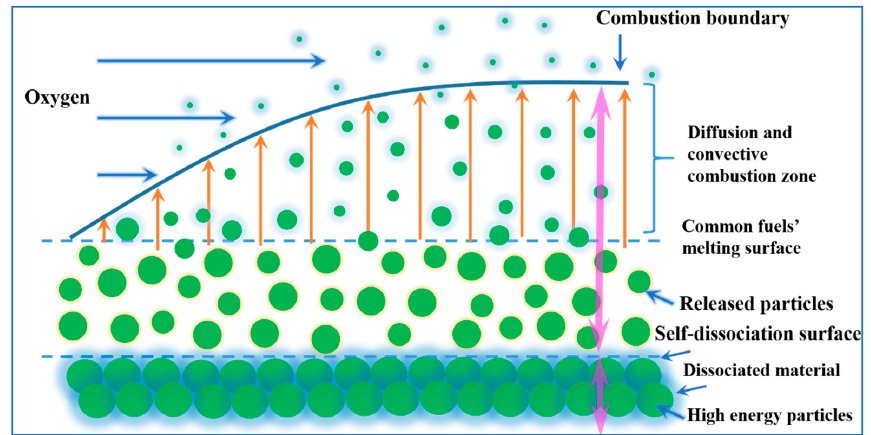
Figure 7. Self-disintegration mechanism of particle / para ffi n composite fuels [28]. Copyright Begell House (2017). Reproduced with